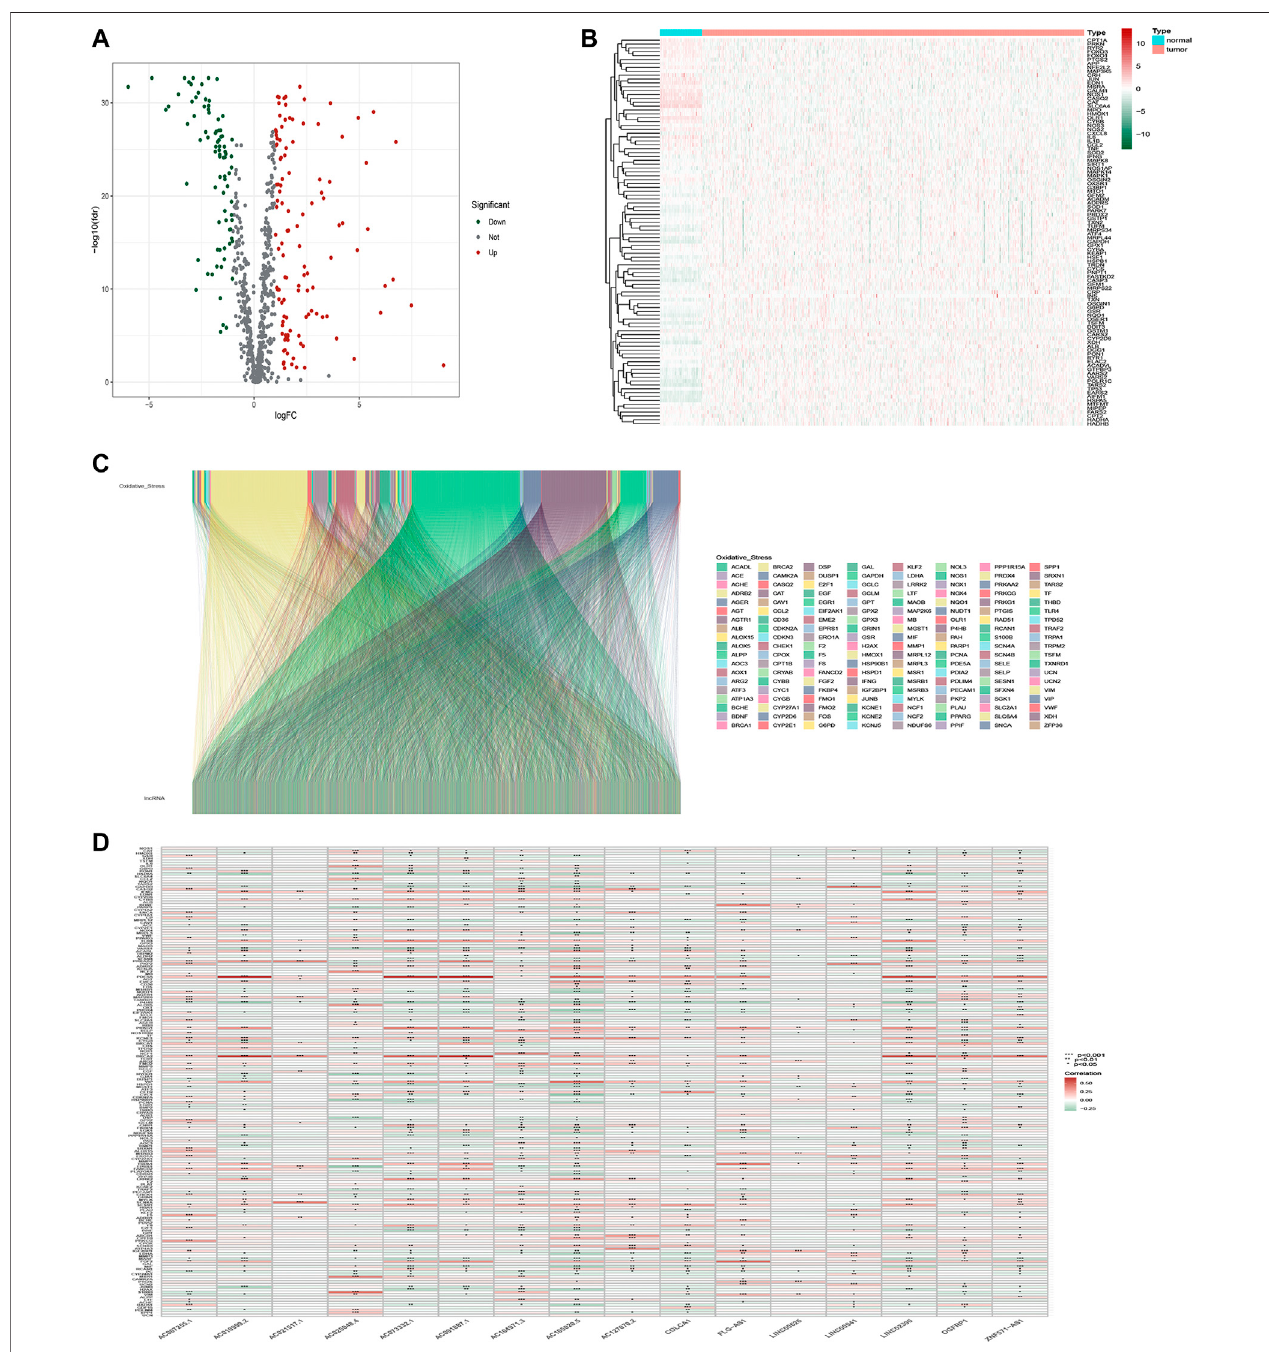
FIGURE 2 | Identi fi cation of oxidative stress-related lncRNAs in LUAD patients. (A) Volcano plot of oxidative stress-associated DEGs in TCGA databases. (B) Heatmap of oxidative stress-associated DEGs in TCGA databases. (C) Sankey relation diagram for differentially expressed oxidative stress genes and oxidative stress- related lncRNAs. (D) Heatmap for the correlations between oxidative stress genes and oxidative stress-related lncRNAs.